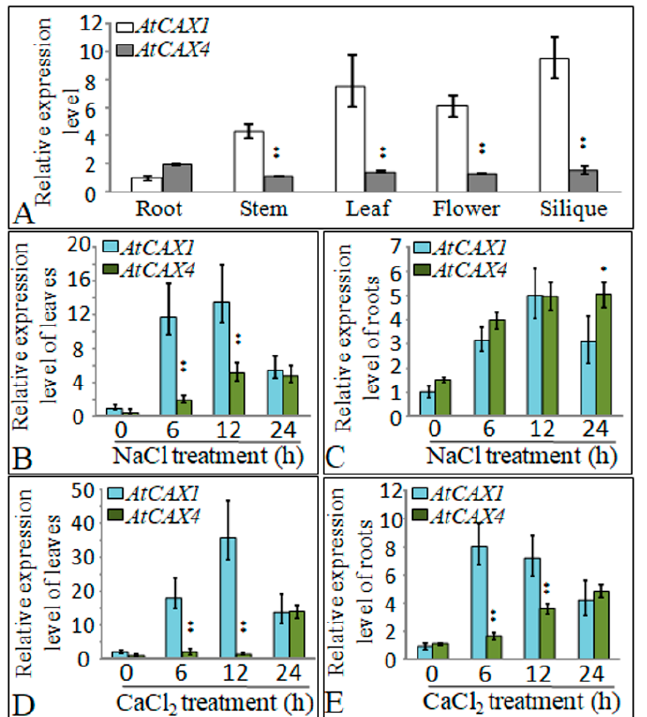
Figure 2 . Expression of AtCAX1 and AtCAX4 in plant tissues subjected to stress conditions. ( A ) RT-qPCR analysis of AtCAX1 and AtCAX4 in different organs of A. thaliana . ( B – E ) RT-qPCR analysis of the expression of AtCAX1 and AtCAX4 in response to various abiotic stresses (see Methods for details). AtCAX1 and AtCAX4 expression was normalized against Actin mRNA levels. The reported data are the means ± SE of three replicate experiments. Single and double asterisks indicate significant differences from wild type (WT) at p < 0.05 and p < 0.01, respectively.